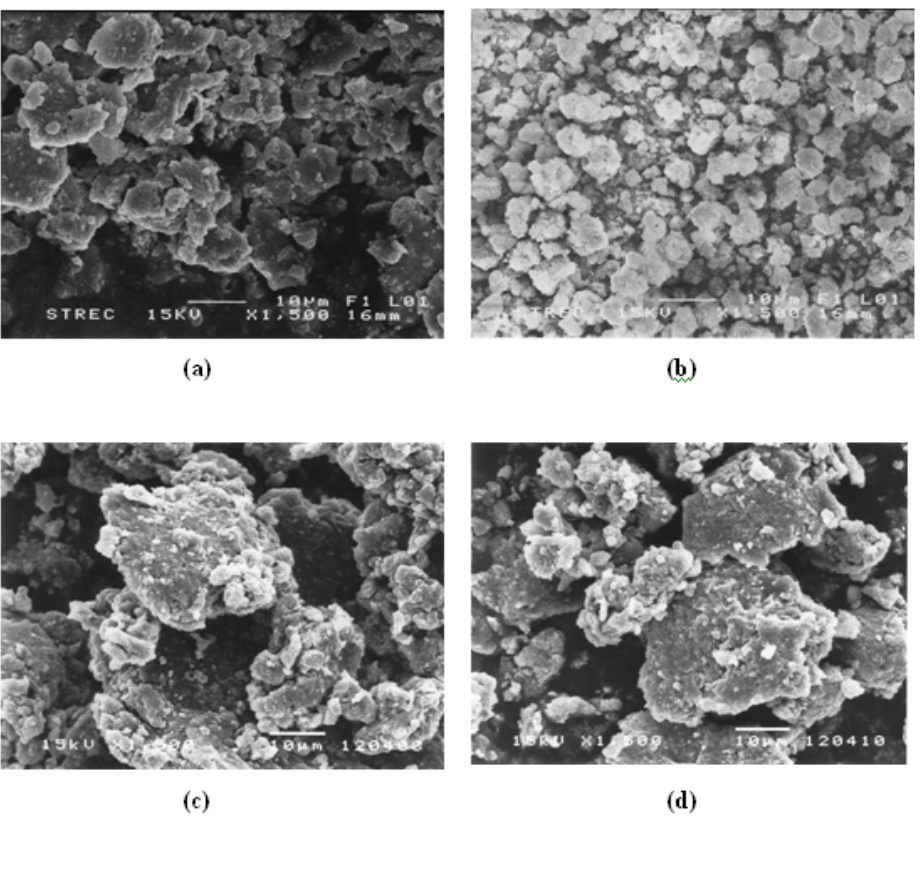
Figure 2. SEM micrographs of powder samples at the magnification 1,500 of: (a) doped PPV; (b) NH 4+ -ZSM5 (Si/Al = 23) before the ion-exchanges; (c) doped PPV/Na + -ZSM5; and (d) doped PPV/Cu +